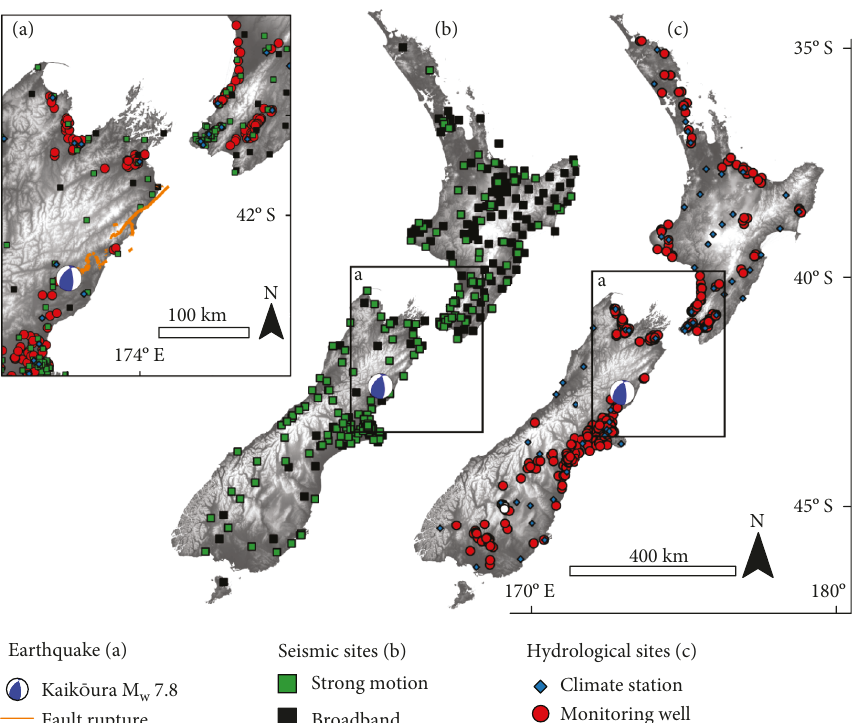
Figure 1: Spatial distribution of the hydrological and seismic dataset that recorded the 2016 M earthquake focal mechanism [5] and surface rupture zone [13]. (b) 306 seismic stations (strong motion and broadband) recorded the Kaik ō ura earthquake. (c) Water level data were collected from 433 monitoring wells, and rainfall and atmospheric pressure were collected from 65 climate stations, which spanned the earthquake interval. Monitoring wells in Cromwell Gorge are highlighted di ff